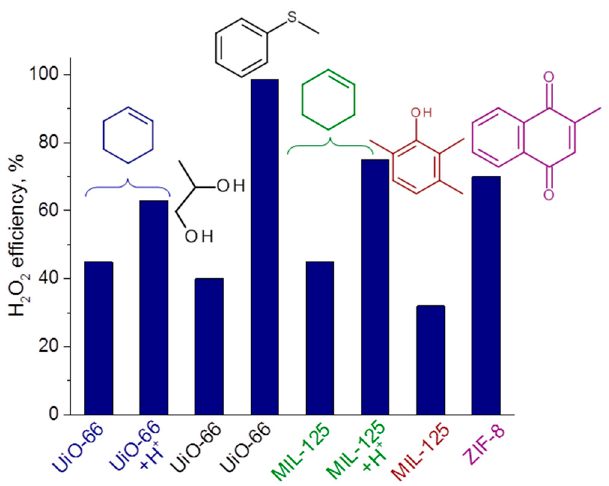
Figure 6. Oxidant utilization efficiency in selective oxidations with 30% H 2 O 2 over MOF catalysts.